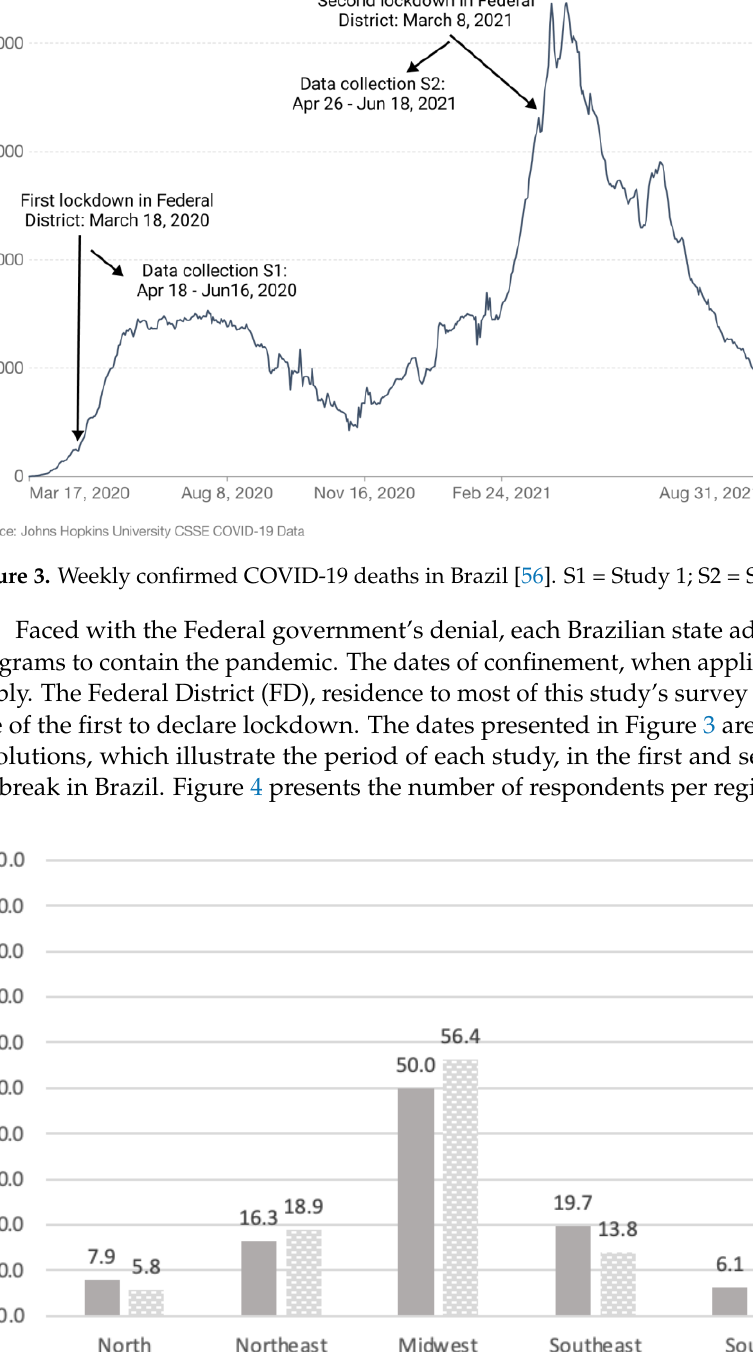
Figure 2. Theoretical model.